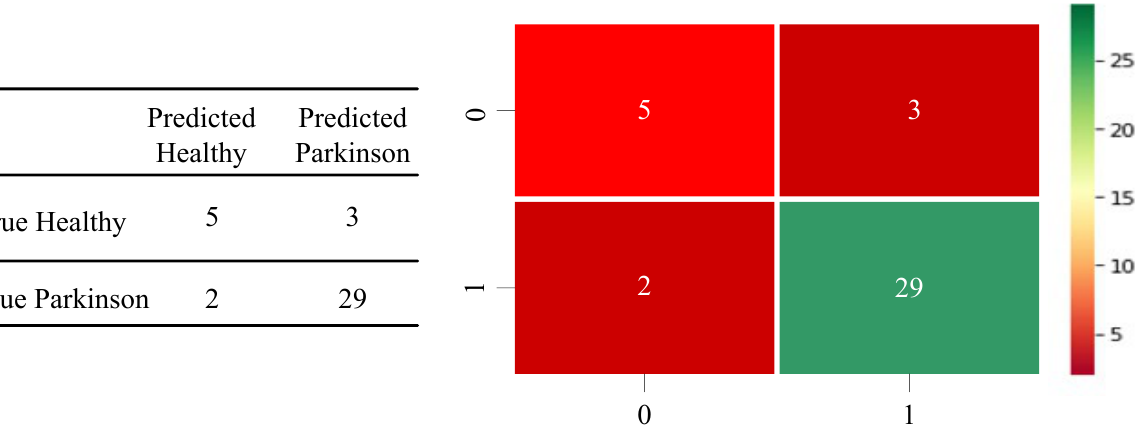
Figure 6. Confusion Matrix and Heatmap of SVM Classifier.